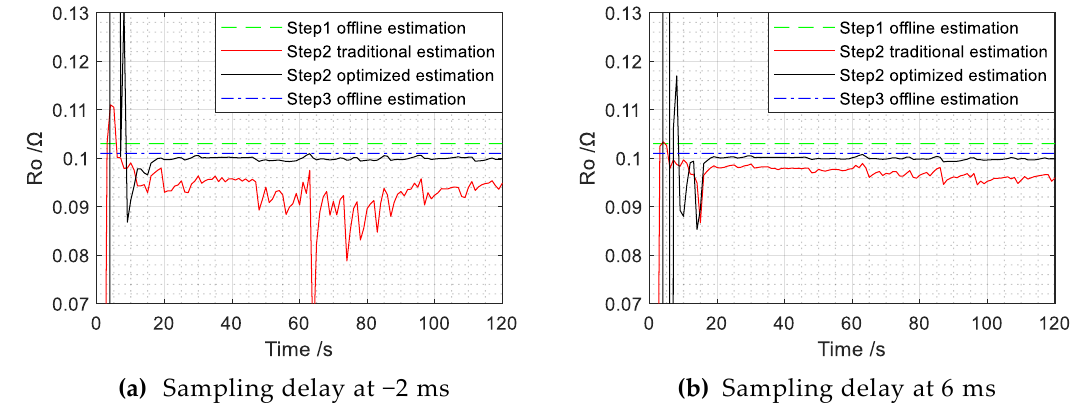
Figure 12. The trajectories of estimated internal resistance obtained by the optimized estimation method with sampling delay at -2 ms and 6 ms.